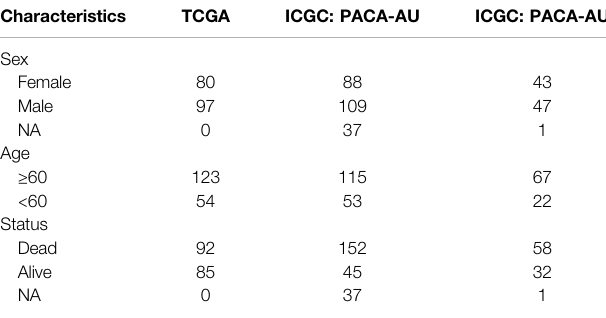
TABLE 1 | Speci fi c clinical information of pancreatic cancer